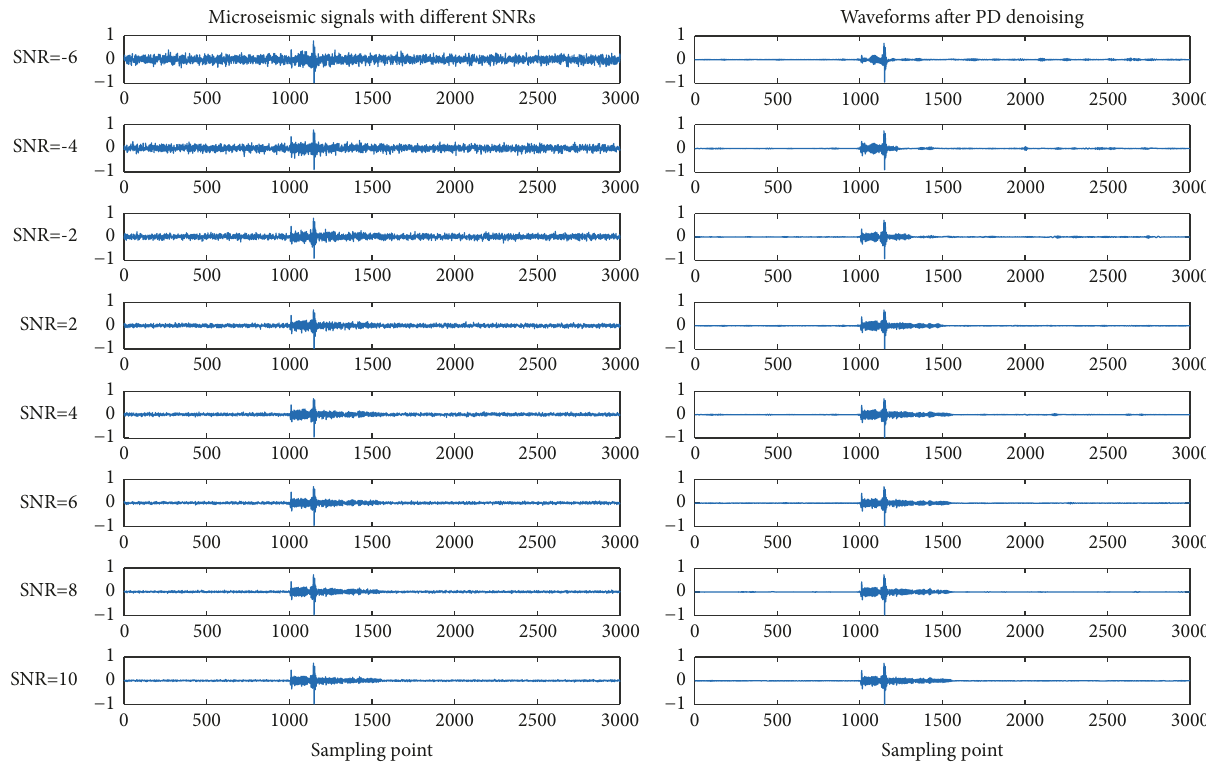
Figure 3: Comparison of signal denoising result with different SNR by PD method.